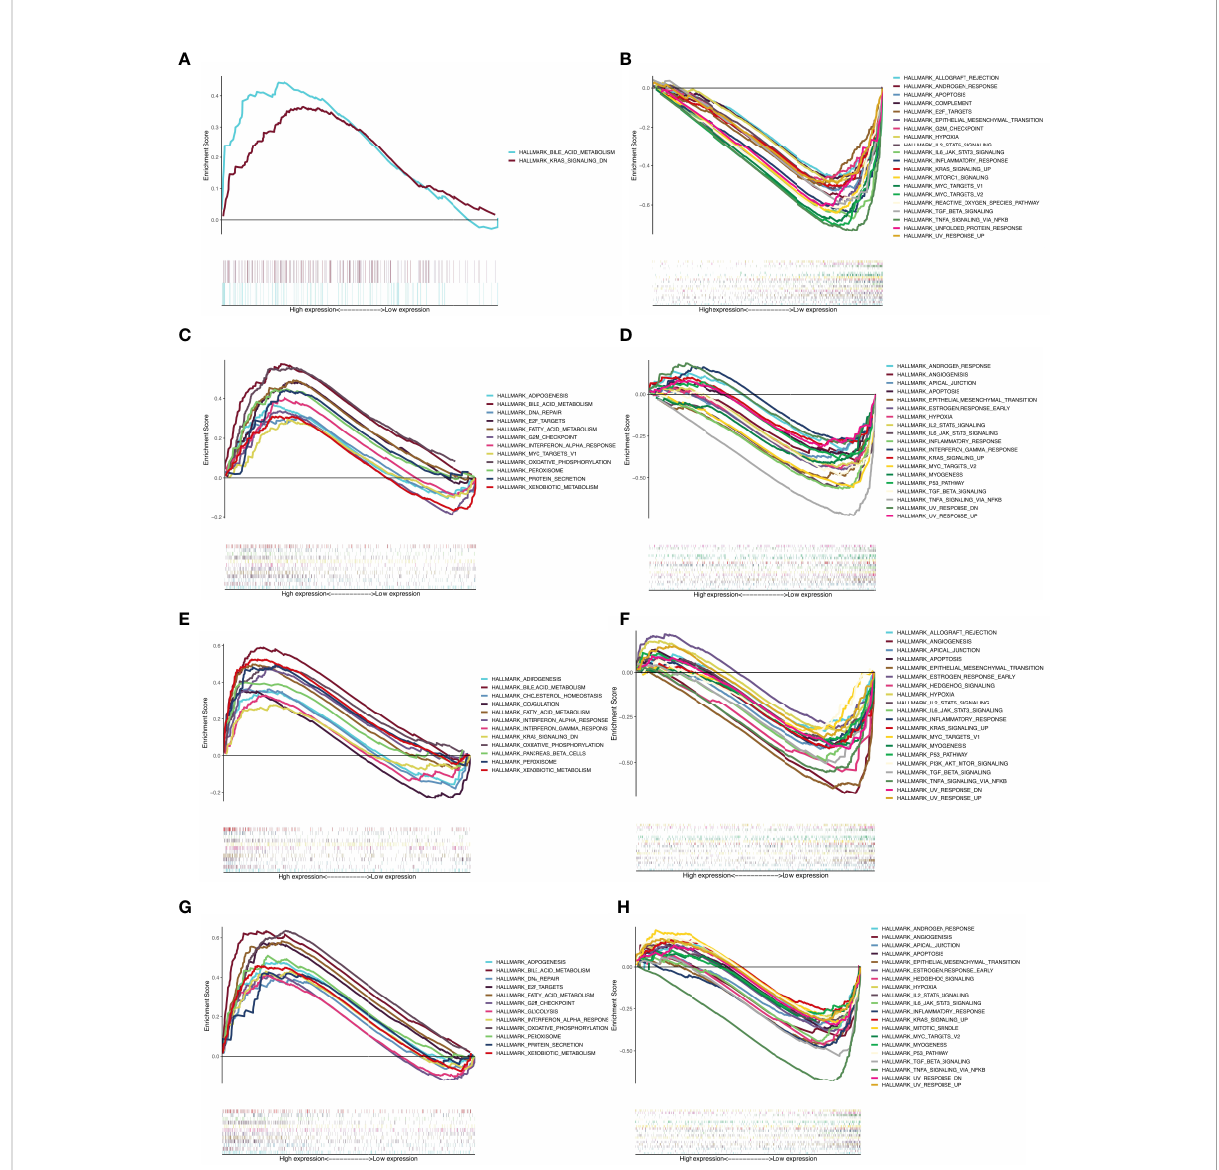
FIGURE 2 GSEA results for the BA group. (A) The enriched pathway in PPAR a high expression group in GSE46960; (B) The enriched pathway in PPAR a low expression group in GSE46960; (C) The enriched pathway in NR1H4 high expression group in GSE46960; (D) The enriched pathway in NR1H4 low expression group in GSE46960; (E) The enriched pathway in PPAR a high expression group in GSE15235; (F) The enriched pathway in PPAR a low expression group in GSE15235; (G) The enriched pathway in NR1H4 high expression group in GSE15235; (H) The enriched pathway in NR1H4 low expression group in